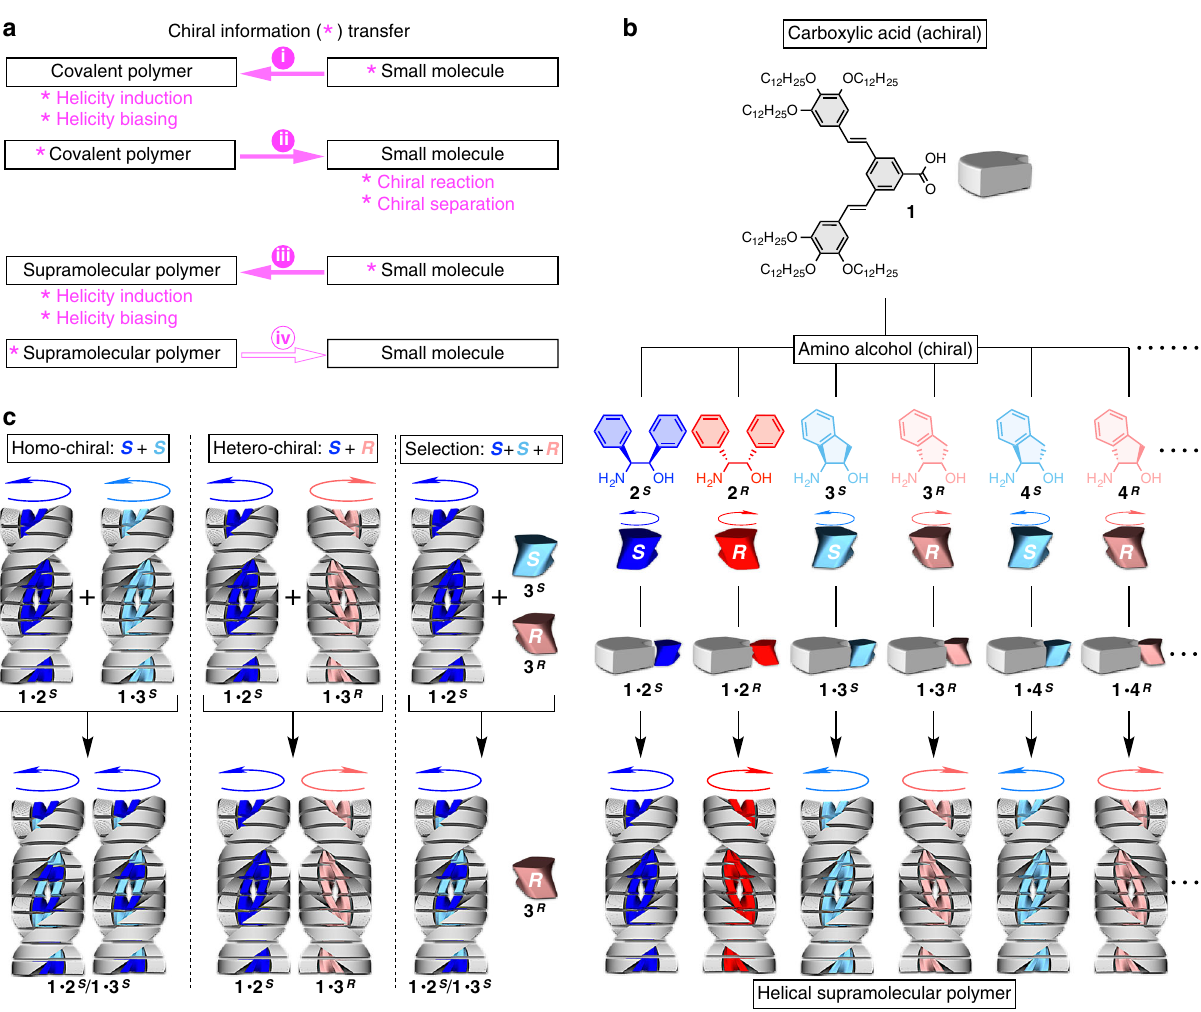
Fig. 1 Design of helical supramolecular polymers with modulable chiral auxiliaries and their application to homo/hetero-chiral recognition. a Schemes for chirality transfer between covalent polymers and small molecules [(i) and (ii)] and between supramolecular polymers and small molecules [(iii) and (iv)]. b Design of the helical supramolecular polymers in this work, whose monomer consists of an achiral main body (dendritic carboxylic acid 1 ) and a chiral auxiliary (amino alcohol X = 2 S / 2 R , 3 S / 3 R , 4 S / 4 R … ) that electrostatically associate to form a salt-pair ( 1 ∙ X ). The monomer 1 ∙ X stacks via hydrogen bonds to form the supramolecular polymer. c Stereoselective copolymerization of two kinds of salts. When mixed in solution, two kinds of salts with the same chirality ( 1 ∙ 2 S and 1 ∙ 3 S ) are copolymerizable (left), while those with opposite chirality ( 1 ∙ 2 S and 1 ∙ 3 R ) are not (middle), because of the matching and mismatching of their helical-handedness preference. Owing to this stereoselective copolymerizability, the polymer of 1 ∙ 2 S accommodate homo-chiral 3 S and reject hetero-chiral 3 R